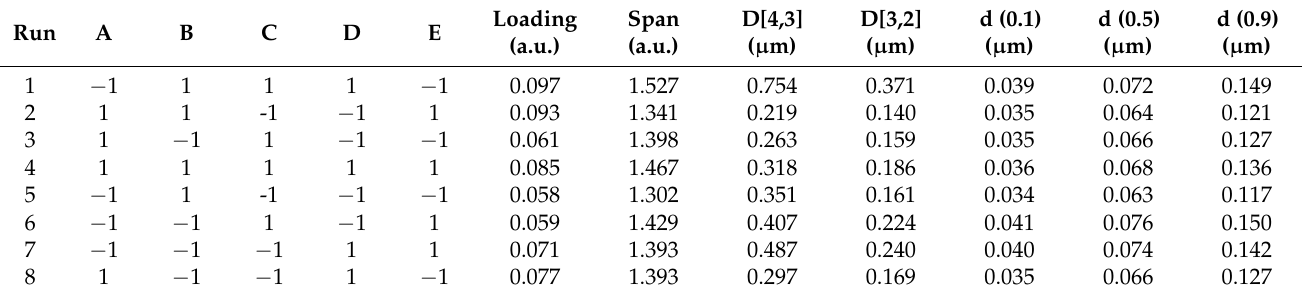
Table 2. D-limonene loading quantification was performed Thermogravimetric analysis, as described in Section 3.3. Table 2. The matrix design for the selected variables, along with the respective